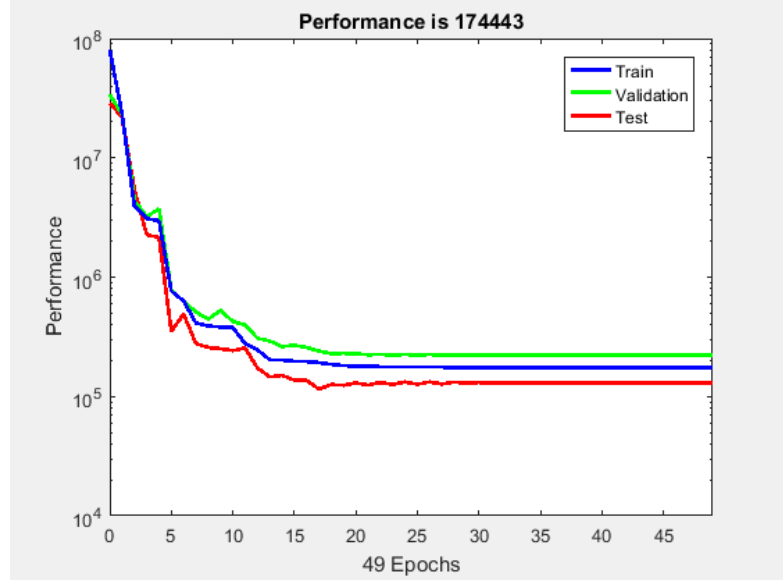
Figure 7. Training performance graph.